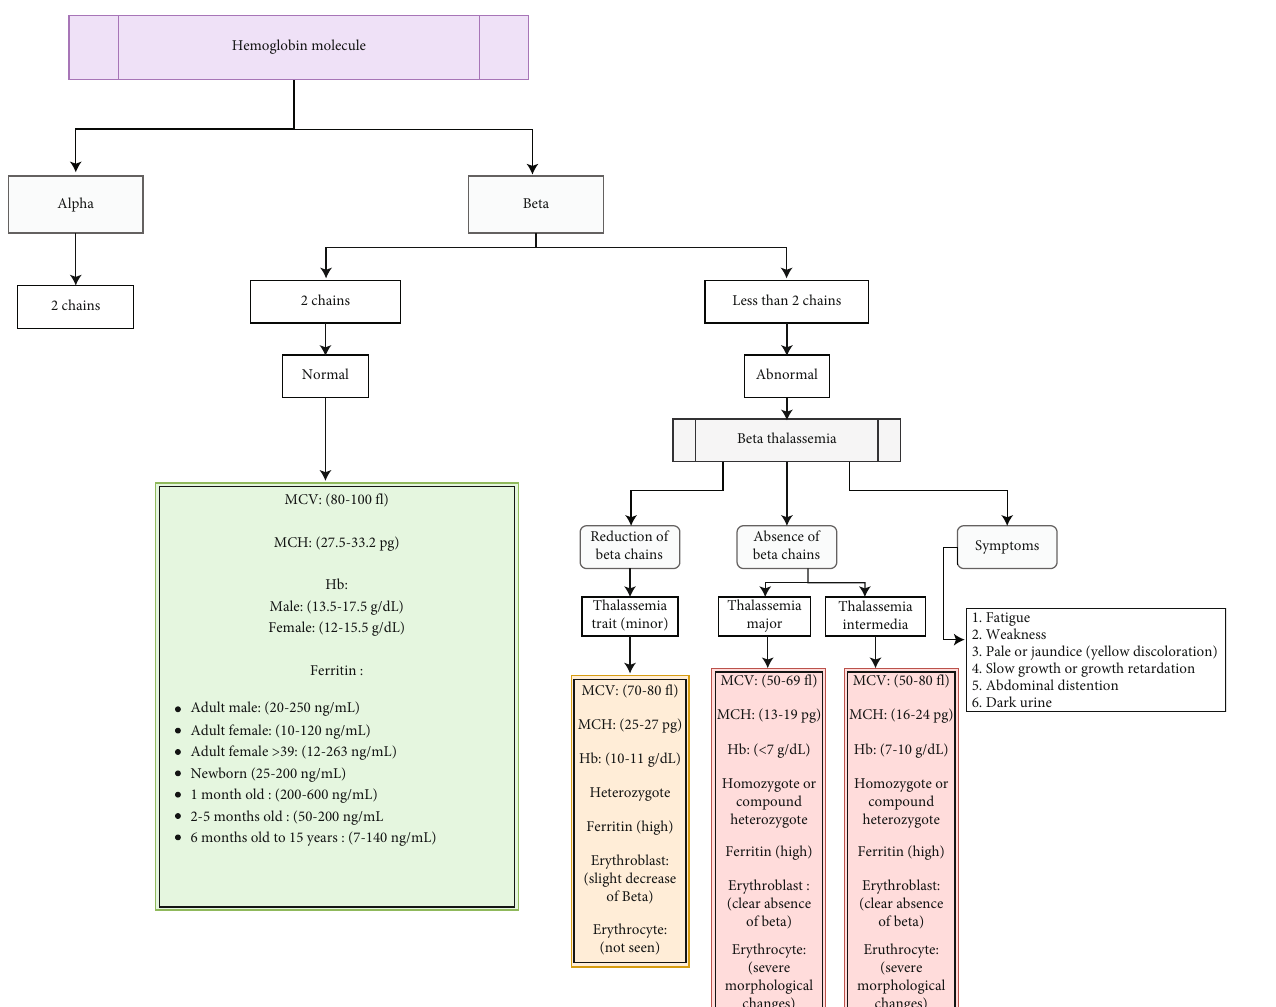
Figure 2: Semantic network representation of di ff erent stages of β -thalassemia symptoms and comparison between normal and abnormal results (MCV, MCH, Hb, Ferritin).